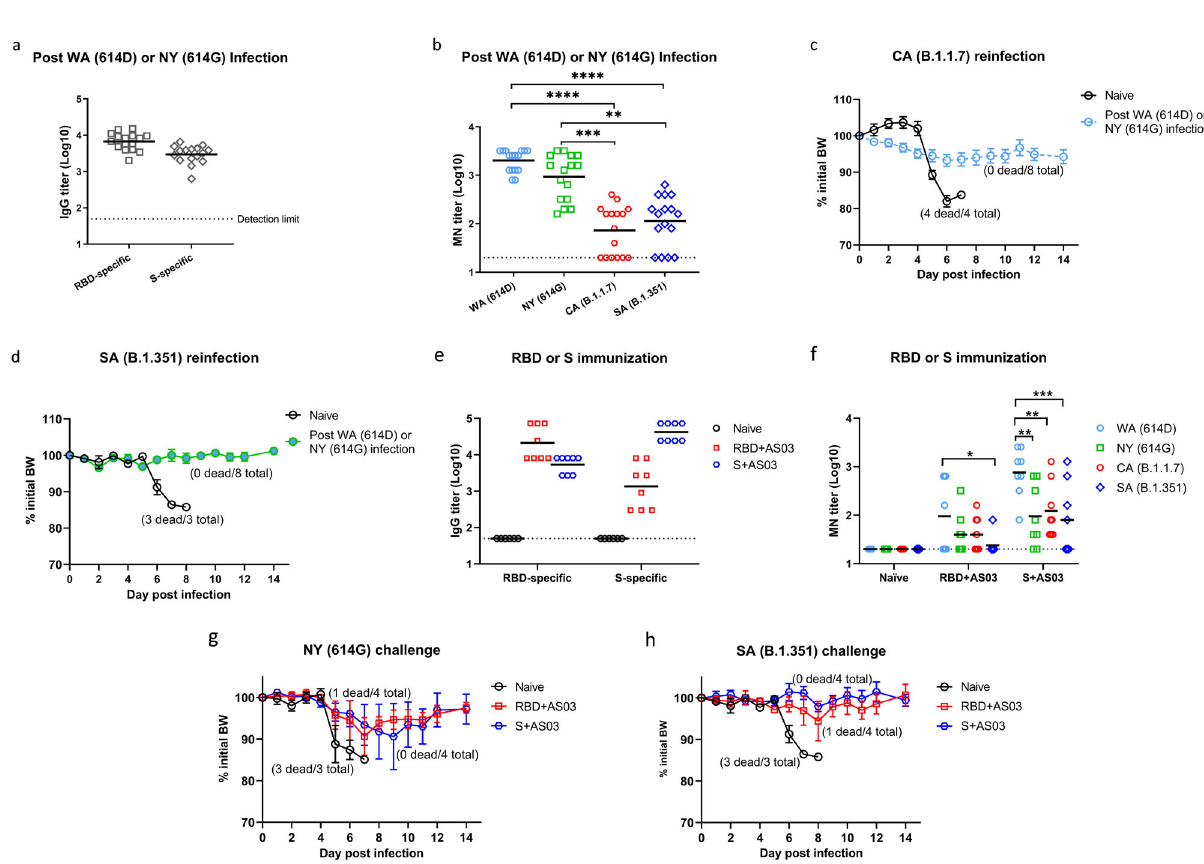
Fig. 9 Antibody responses, morbidity and mortality following reinfection or challenge of SARS-CoV-2 SA variant. K18-hACE2 mice that survived from prior infection of USA-WA1/2020 (WA) of lineage A bearing 614D or New York-PV09158/2020 (NY) of lineage B.1.3 bearing 614G were reinfected at 6 – 8 weeks later with USA/CA_CDC_5574/2020 (CA) of lineage B.1.1.7 or hCoV-19/South Africa/KRISP-EC-K005321/2020 (SA) of lineage B.1.351 at the dose of 10 2 TCID 50 /mouse in an ABSL-3 biocontainment. Right before reinfection, mouse sera were analyzed for ( a ) IgG titers speci fi c for spike (S) or receptor binding domain (RBD) by ELISA or ( b ) microneutralization (MN) titers for SARS-CoV-2 and variants ( n = 16 mice/group). Body weight (BW) and survival of mice from prior infection ( n = 8 mice/group) and naïve K18-hACE2 mice ( n = 3 mice/group) were monitored for two weeks after reinfection of ( c ) CA (B.1.1.7) or ( d ) SA (B.1.351) variant. Separate sets of K18-hACE2 mice were immunized intramuscularly with RBD or S emulsi fi ed with AS03-like adjuvant and were challenged with 10 3 TCID 50 /mouse of NY (614G) or 10 2 TCID 50 /mouse of SA (B.1.351). ( e ) Serum IgG ELISA titers speci fi c for RBD or S or ( f ) MN titers for SARS-CoV-2 and variants before challenge ( n = 8 mice/group). BW and survival of immunized mice ( n = 4 mice/group) and naïve K18-hACE2 mice ( n = 3 mice/group) were monitored for two weeks after challenge of ( g ) NY (614G) or ( h ) SA (B.1.351) variant. Short lines represent geometric means and dotted horizontal lines indicate the limit of detection. BW are expressed as mean ± s.e.m. * p < 0.05, ** p < 0.01, *** p < 0.001 and **** p < 0.0001 by one-way nonparametric ANOVA with Dunn ’ s multiple comparisons test after log-transformation of MN titers. ( d ) and ( h ) were conducted at the same time with the same naïve mice as the